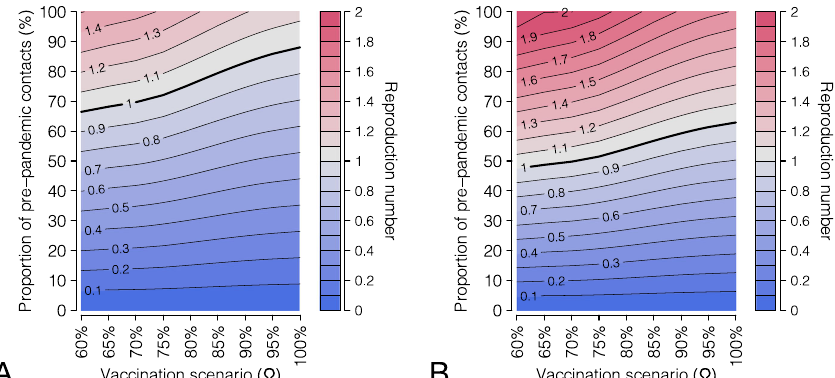
Fig. 5 Sensitivity analysis with respect to the transmissibility increase of the Delta with respect to the Alpha variant. Heatmap of the mean projected reproduction number for different vaccination scenarios ( x axis) and different levels of social activity (y axis), n = 300 stochastic model realizations, under a transmissibility increased by A ) 25% and B ) 75%, compared to the